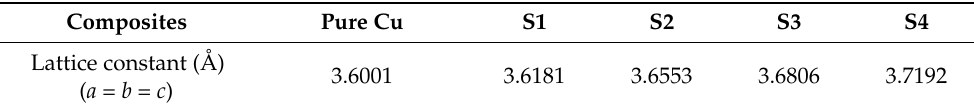
Table 1. Calculated lattice constant of Cu based on the XRD patterns. Composites